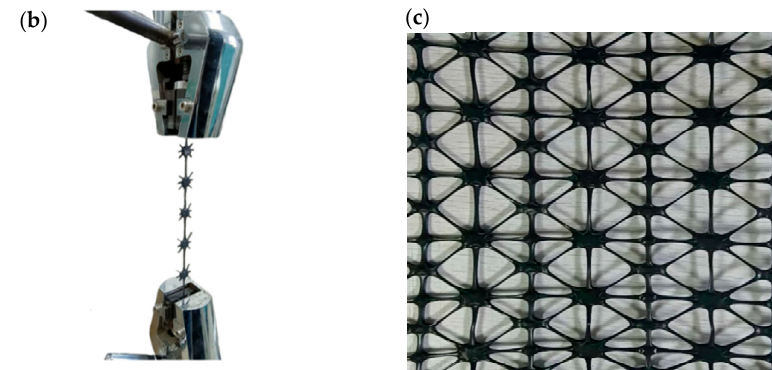
Figure 9. Test method for mechanical properties of single rib method. ( a ) Simple (90° sub-rib). ( b ) Single rib clamping method. ( c ) POMG with circular and semicircular holes. Table 2. Tensile strength of performance-optimized multi-axial geogrid with different holes (KN/m).